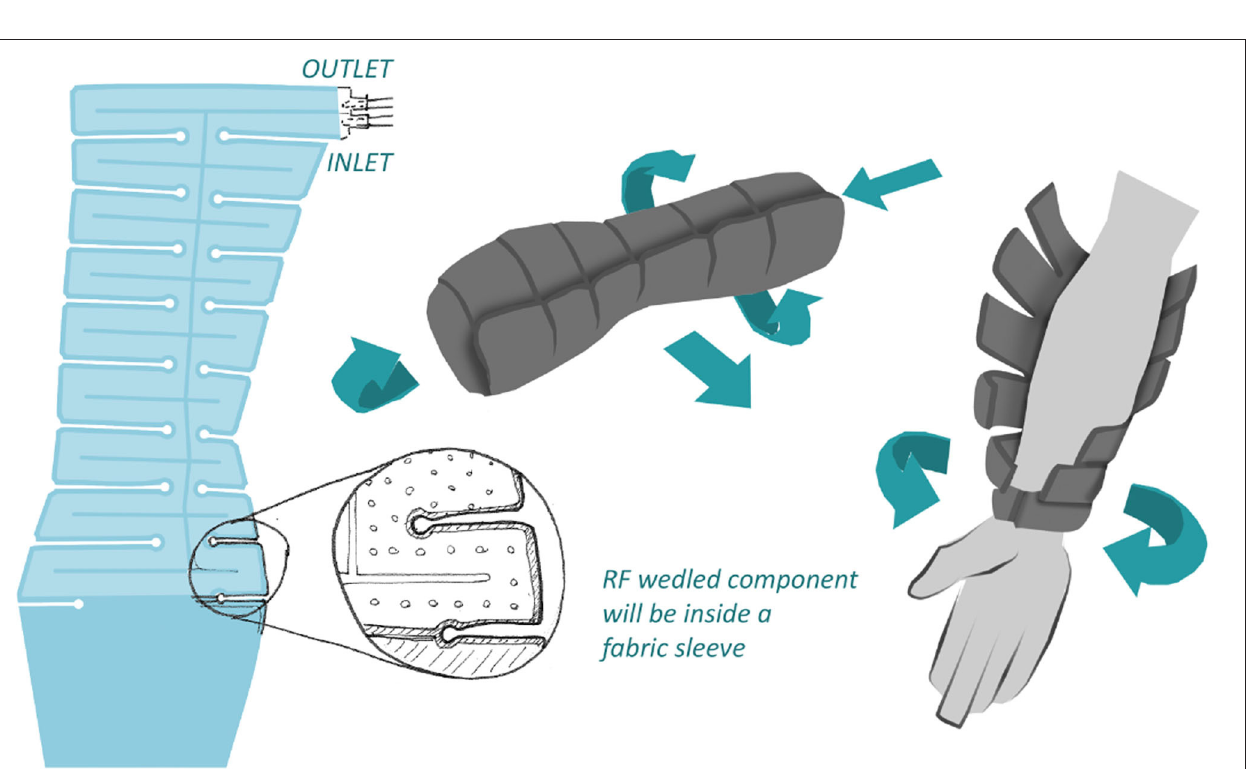
FIGURE 10 | Limb cooling wrap concept developed based on the Focus group